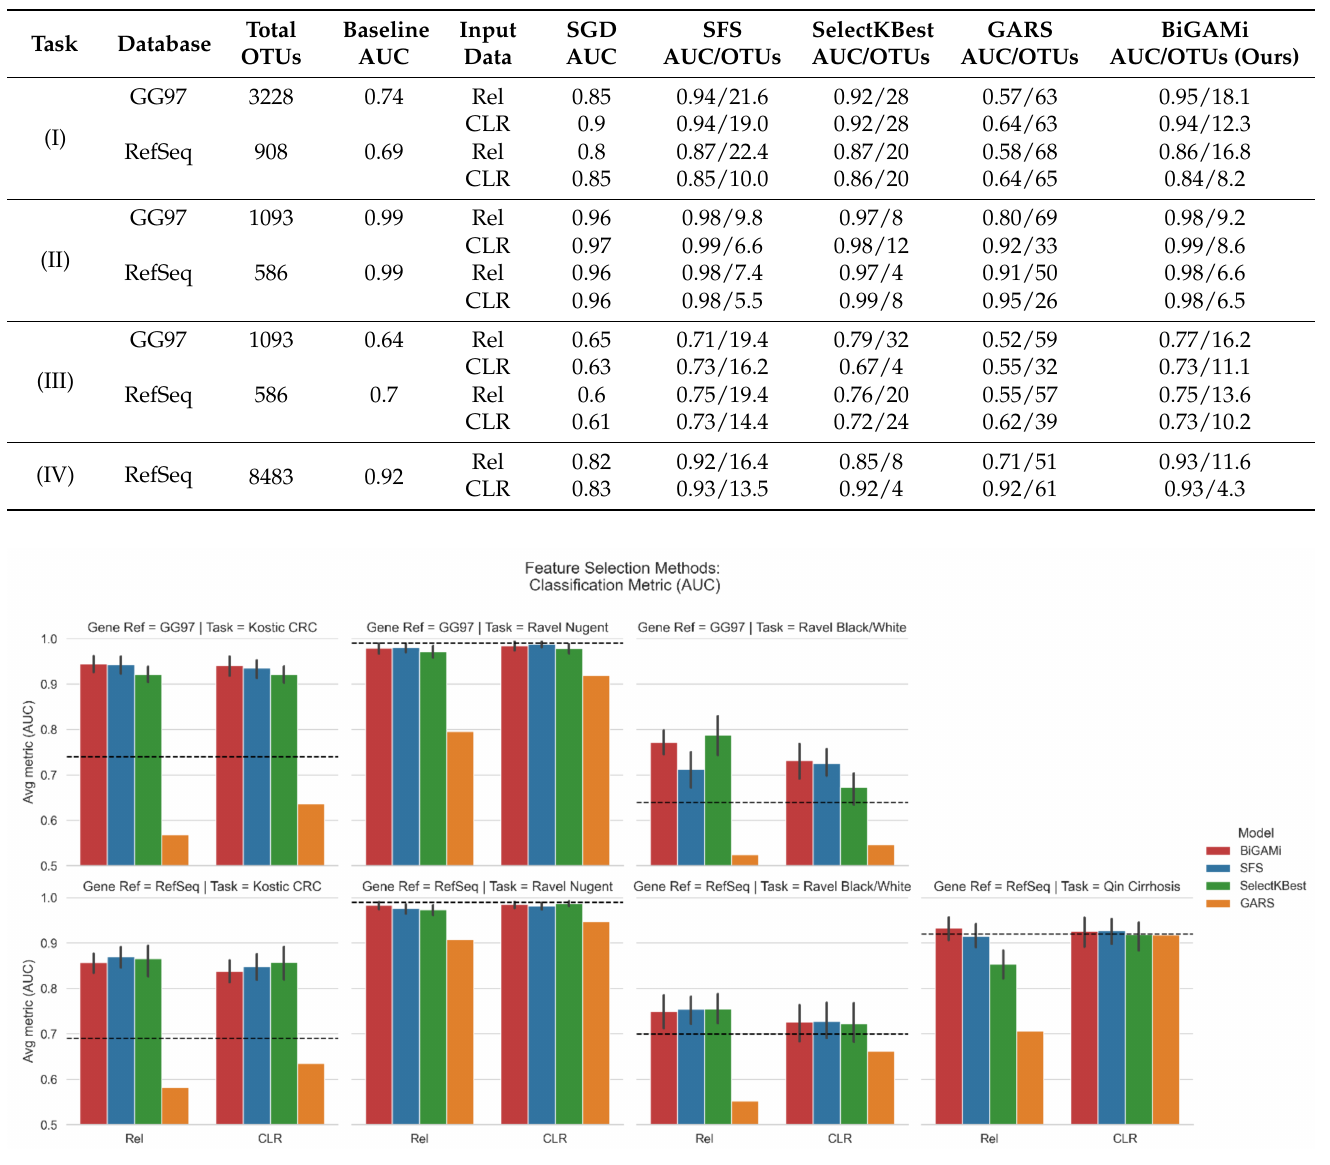
Figure 3. Average classification performance (including 99% confidence interval) for each data input achieved by the BiGAMi, SFS, and GARS methods. Confidence intervals were calculated by the Seaborn plotting library using the bootstrap resampling technique with a mean estimator. The dashed horizontal lines represent the base performances as documented by Ref [29]. ( Top ): Performance results for GG97-based data input. ( Bottom ): Performance results for RefSeq-based data